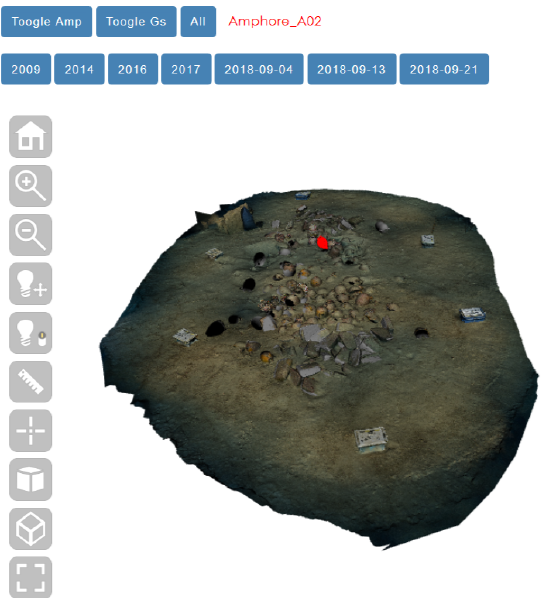
Figure 5: 3D view of Xlendi Orthophoto in our 3D web tool (pow- ered by 3DHop).